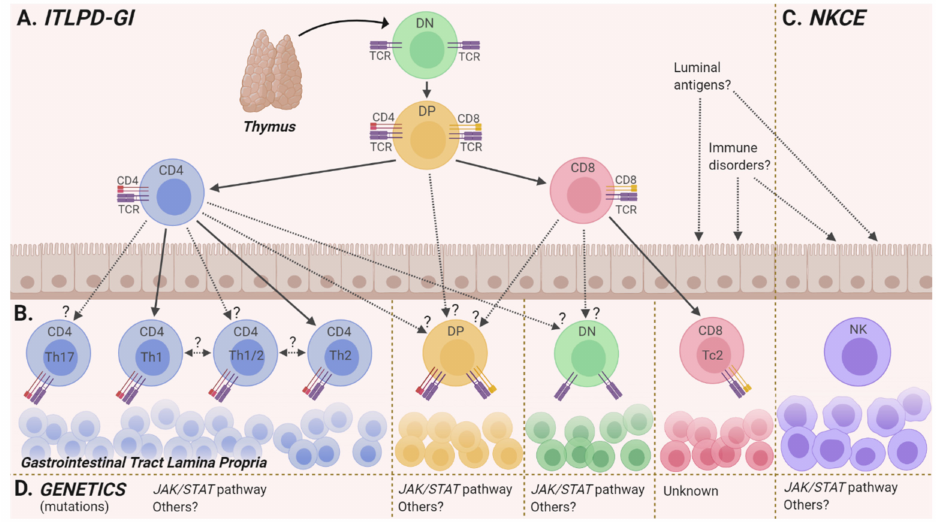
Figure 2. Pathogenetic aspects of ITLPD-GI and NKCE: ( A ) During “normal” T-cell development, immature double-negative (“DN”) thymocytes give rise to double-positive (“DP”) thymocytes in the thymus, which subsequently express either CD4 or CD8 following positive and negative selection. ( B ) Mature T-cells migrate to the gastrointestinal tract lamina propria. CD4 + ITLPD-GI manifest Th1, Th2, or hybrid Th1/2 profiles; acquisition of a Th17 fate has not been excluded. CD8 + cases predominantly display a Tc2 profile. It is not known whether the rare DP cases derive from DP thymocytes, which migrate directly to the intestinal mucosa, or from single-positive T-cells which up-regulate CD4 + or CD8 + . DN ITLPD-GI may derive from activated CD4 + or CD8 + T-cells that have downregulated the T-cell co-receptors. ( C ) The cell of origin of NKCE (tissue-resident or circulating NK-cells) is unclear. The inciting factors for ITLPD-GI and NKCE (local or systemic) have not been elucidated. ( D ) Genetic alterations in the JAK/STAT signaling pathway have been identified in most immunophenotypic subsets of ITLPD-GI and in